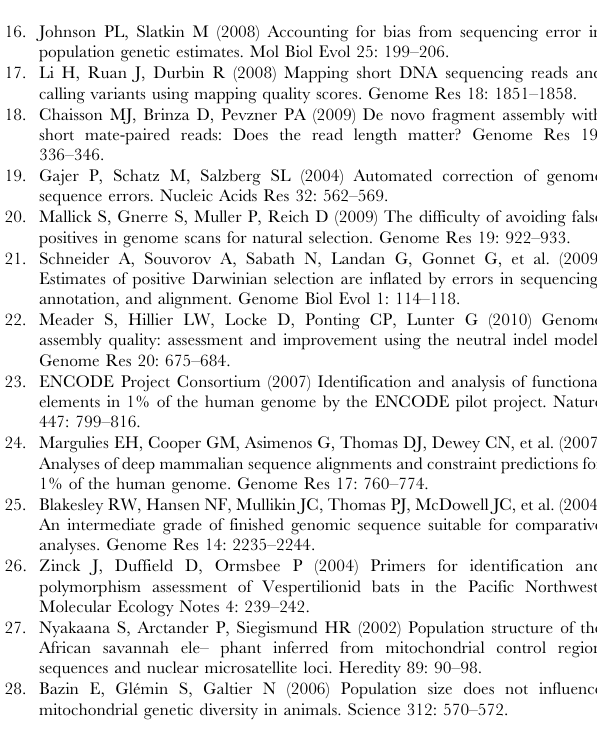
Figure S5 Empirical cumulative distribution functions (CDFs) for single-read quality scores in various assem- blies. This figure is based on a random sample of , 10,000 reads per assembly, and only represents the portion of each read which is used in the assembly. Tree shrew (shown in bold) was chosen as a representative species whose distribution was used in our model for coverage and error.